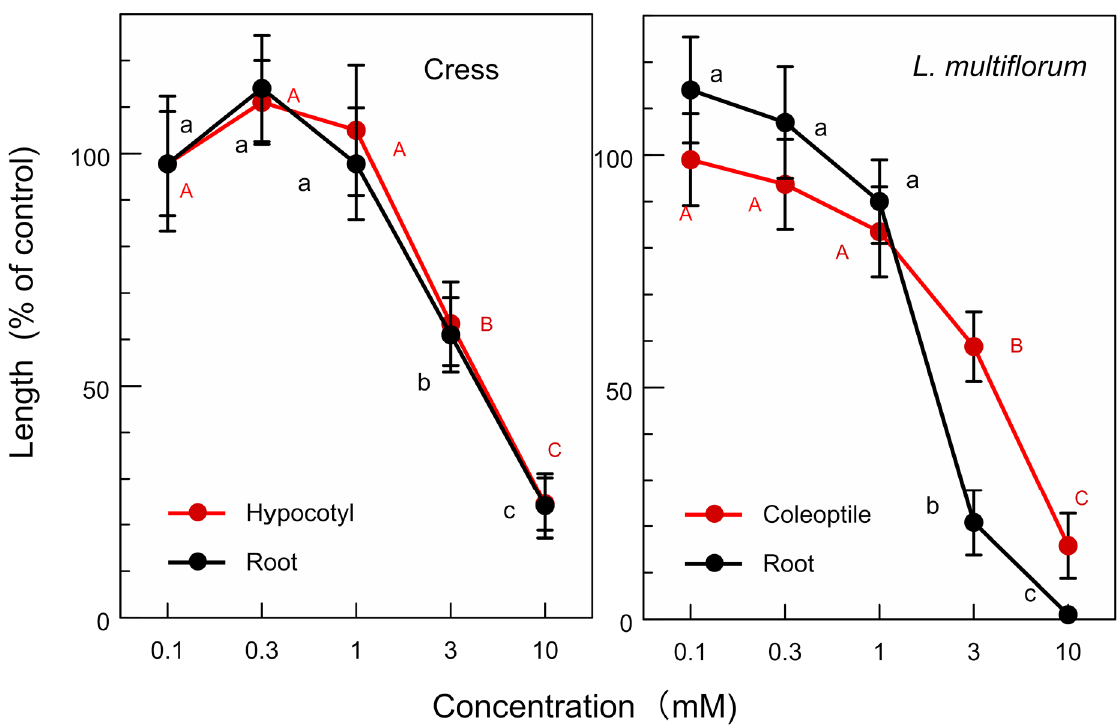
Figure 9. Effects of 10-acetoxyligustroside on the hypocotyl/coleoptile and root growth of cress and L. multiflorum. Means ± SE from three independent experiments with 10 seedlings for each determination are shown. Different letters on the symbols in the same panels indicate significant differences (Tukey’s HSD test, p ≤ 0.05).